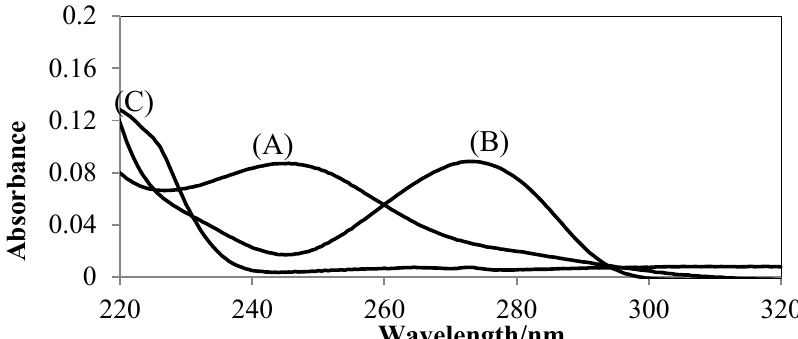
Figure 2: Absorption spectra of paracetamol (A), ibuprofen (B) and caffeine (C) at B-R buffer pH 11.0. The concentration of each component is 10 µmol L -1 .